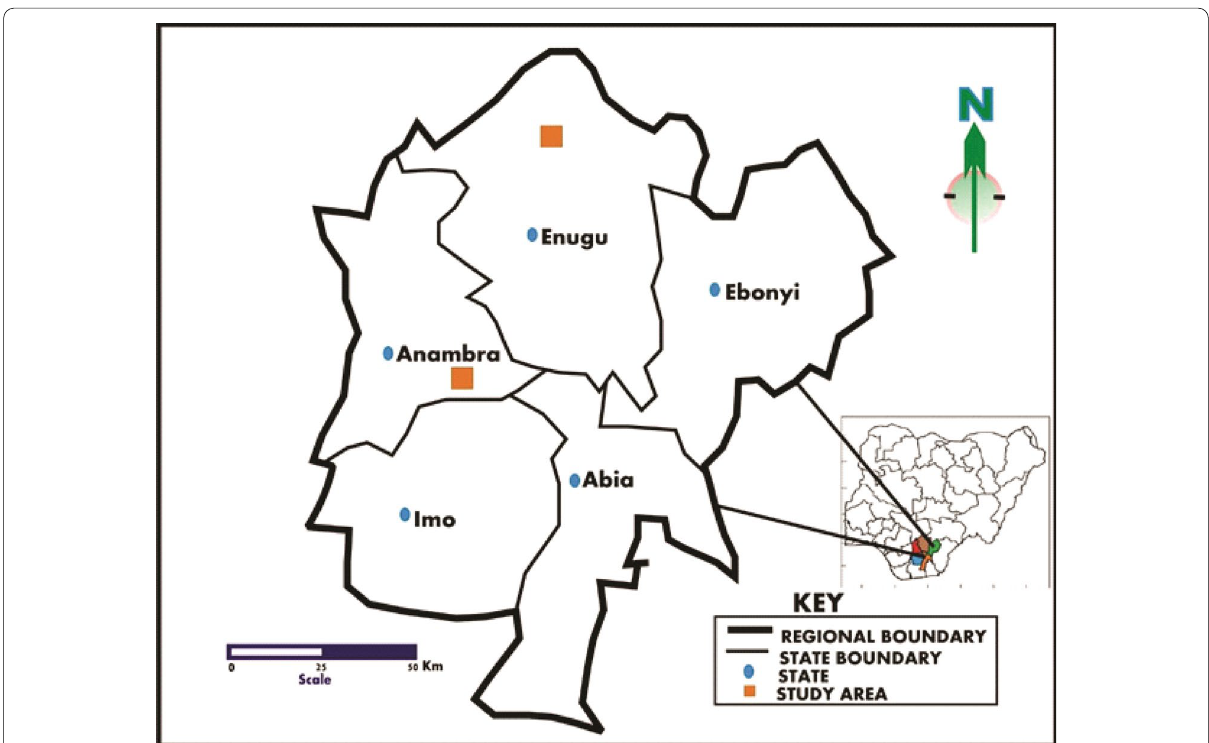
Fig. 1 Map of Southeastern Nigeria Showing the Study area (Anejionu et al. 2013; Egboka et al.